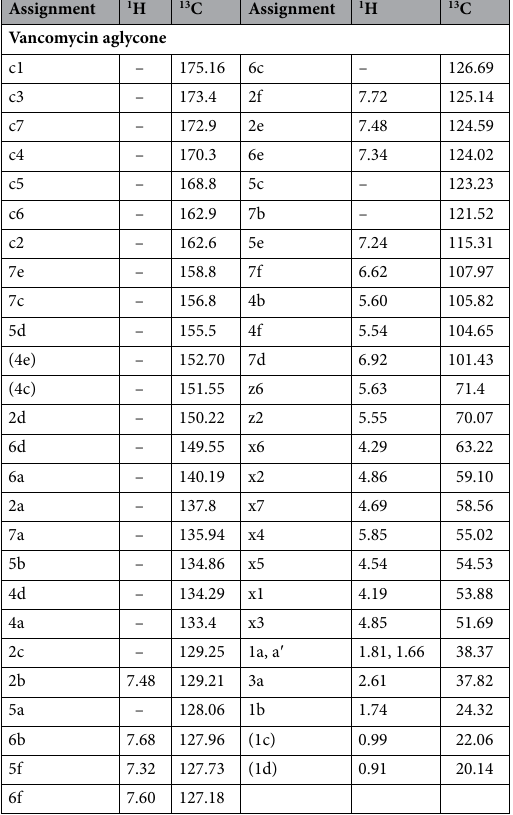
Table 1. NMR assignments for the vancomycin aglycone part of compound 14.